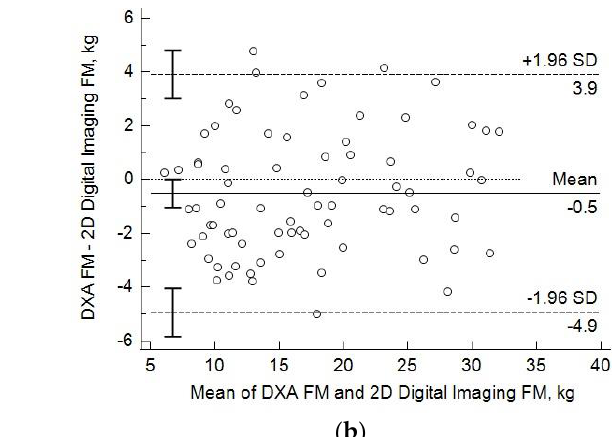
limits of agreement (LOA; mean ± 1.96 SD) ranged from 4.9 to −4.3 kg and from 3.9 to −4.9 kg for females and males, respectively.